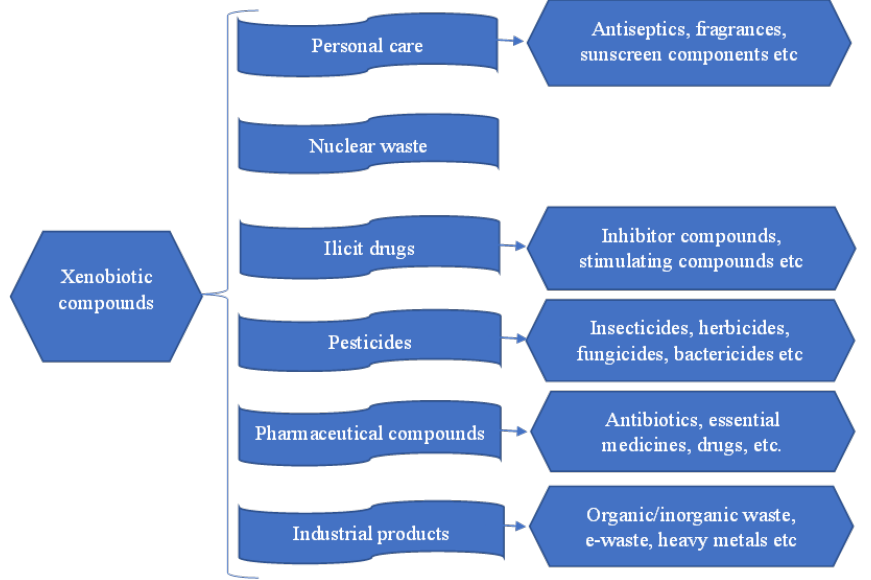
Figure 11. Xenobiotic compounds (modified from [99]).